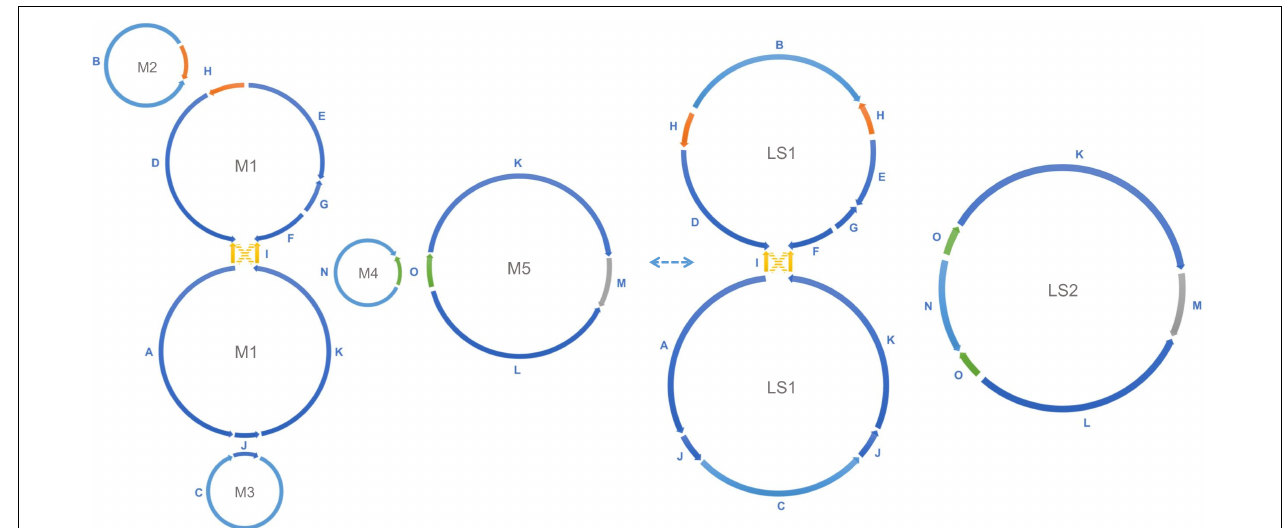
FIGURE 3 | Recombination between repeats forms alternative mitochondrial genomic conformations. Recombination across the direct repeats H (orange), J (blue), and O (green) merges the five small circular molecules into two large rings. M2 and the upper ring of M1 are merged into the upper ring of LS1, the lower ring of M1 and M3 form the lower ring of LS1, and the M4 and M5 are merged into LS2, as shown in the figure. This transformation is reversible. Recombination between a single pair of inverted repeats I (yellow) changes the connection between the upper M1/LS1 ring and the lower M1/LS1 ring (AID, KIF to AIF, KID). The connection shown by the yellow solid line and the connection shown by the yellow dashed line are interchangeable through recombination. All structures mentioned above are experimentally verified in the data.